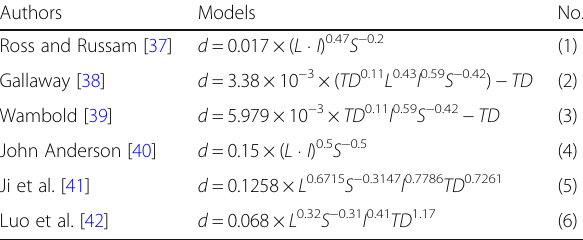
Table 2 Prediction models for water film thickness Authors